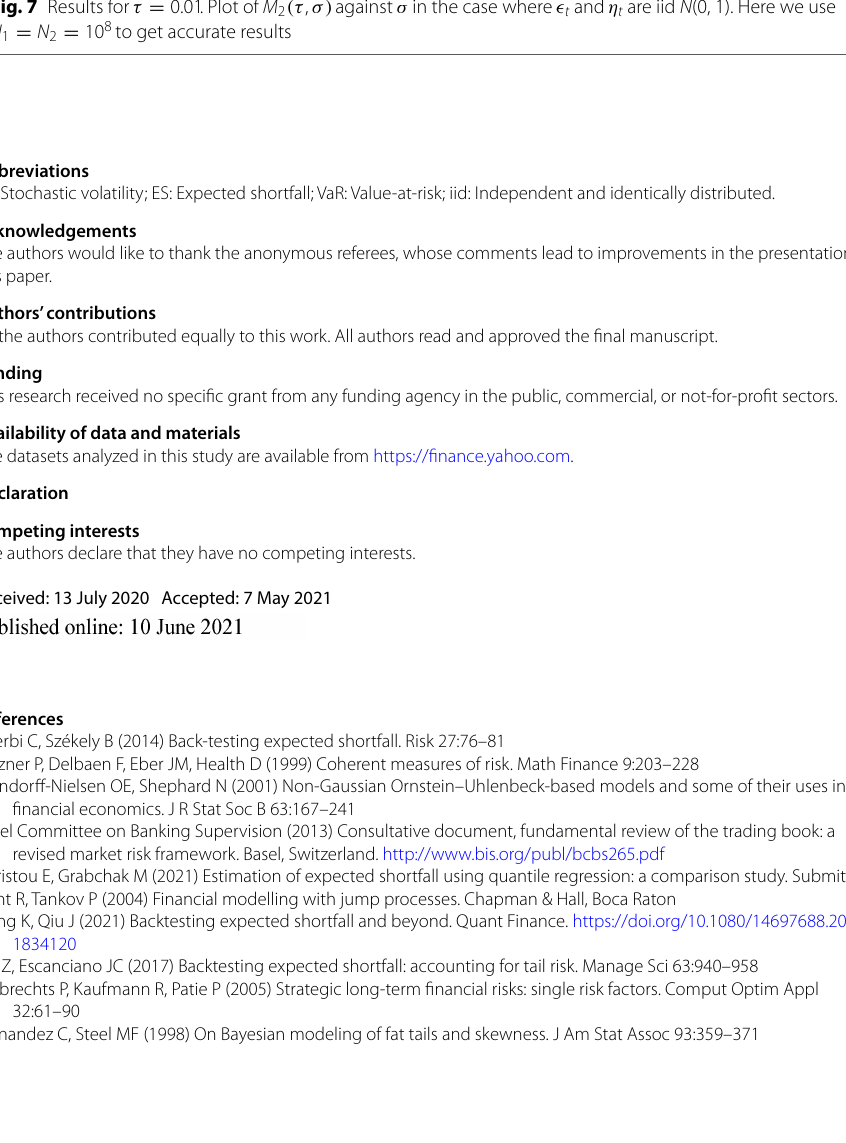
Fig. 7 Results for τ